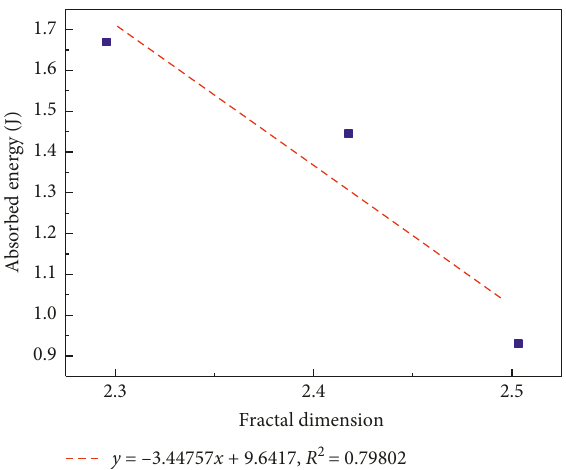
] − ln [ r / r m ] curve in the SHPB test. / m r T